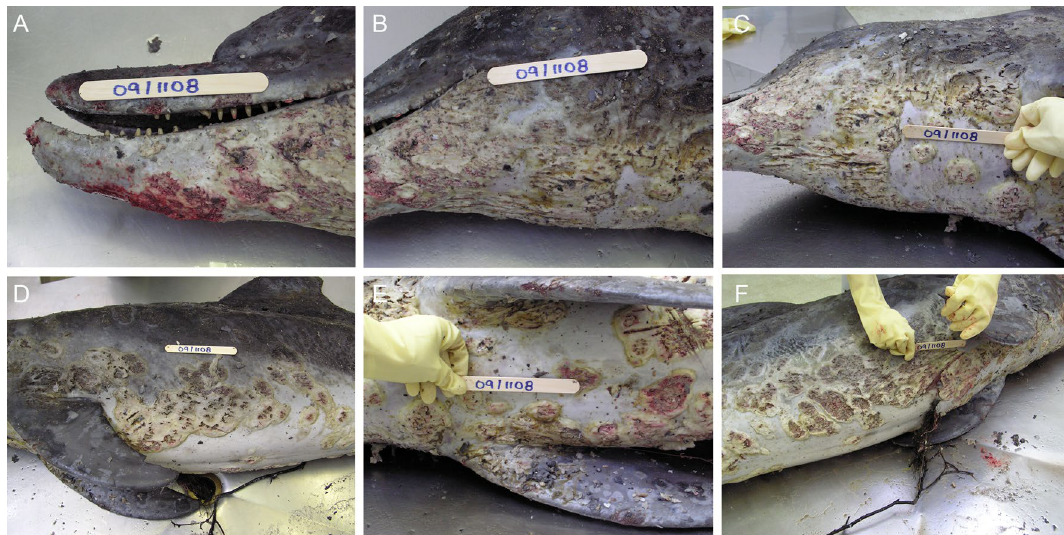
Figure 4. Adult female T. aduncus (case 4) that died in the Swan-Canning Riverpark on 25th October, 2009. There are extensive circular or targetoid, discrete to confluent plaques and ulcers affecting the mandible and rostrum ( A ), face and neck ( B ), ventral neck and thorax ( C ), the left left flank and pectoral flipper ( D ), sternum and plantar pectoral flippers ( E ), right abdomen and thorax ( F